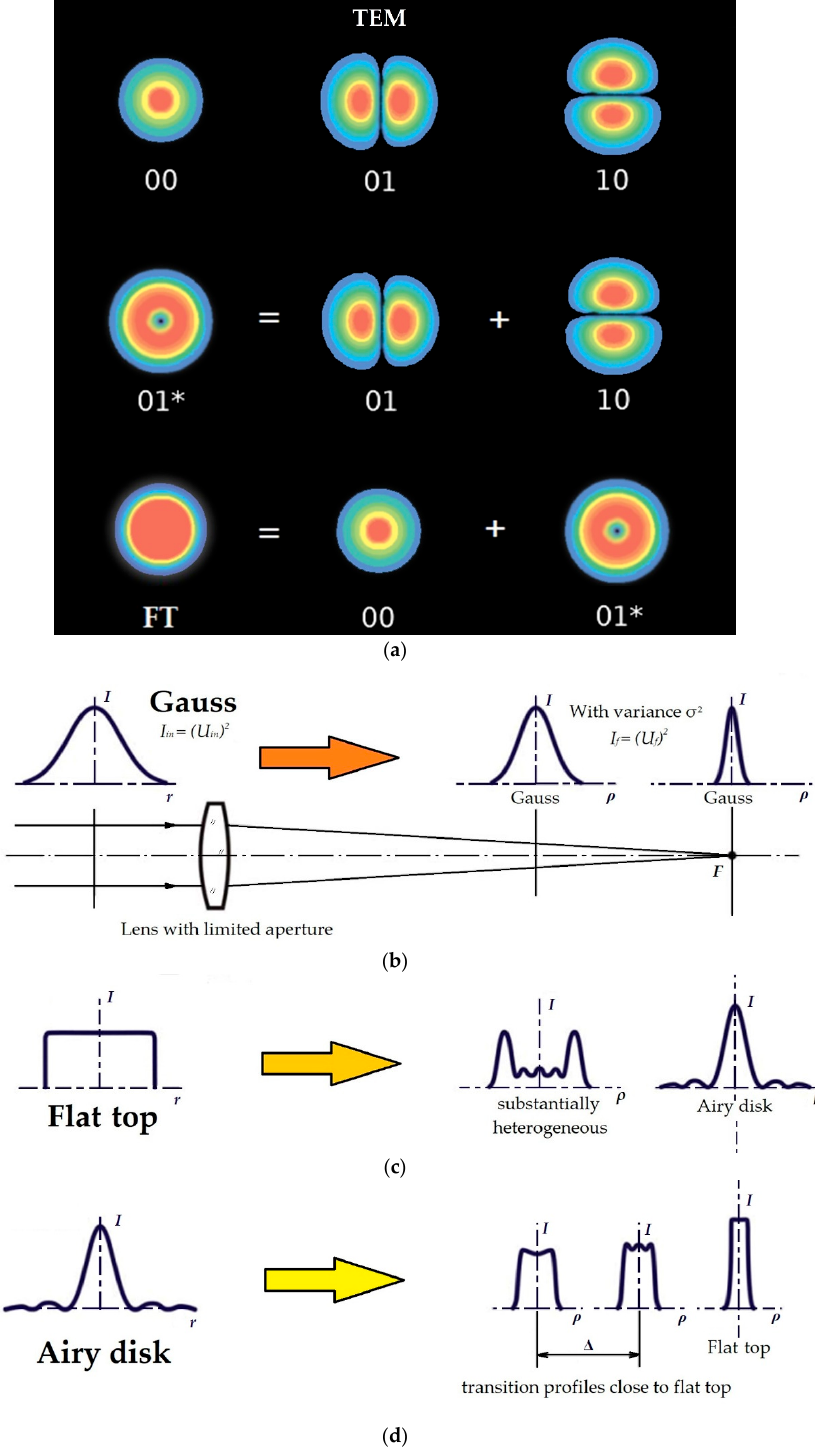
Figure 2. The change in the intensity of the radiation profile depending on the characteristics of an input laser beam: ( a ) simplified presentation of laser beam mode in plane; ( b ) Gaussian beam; ( c ) flat-top or top-hat beam; ( d ) Airy disk; I in is intensity of input beam, W · m − 2 ; I f is intensity of focused beam, W · m − 2 ; U in is the complex amplitude of the electric field for input beam, V; U f is the complex amplitude of the electric field for focused beam, V; r is an effective radius of input beam, µ m; (cid:36) is an effective radius of focused beam, µ m; σ 2 is the variance or measure of the spread of random values, non-dimensional; F is focus, optical point of the system ; ∆ is the distance between intermediate